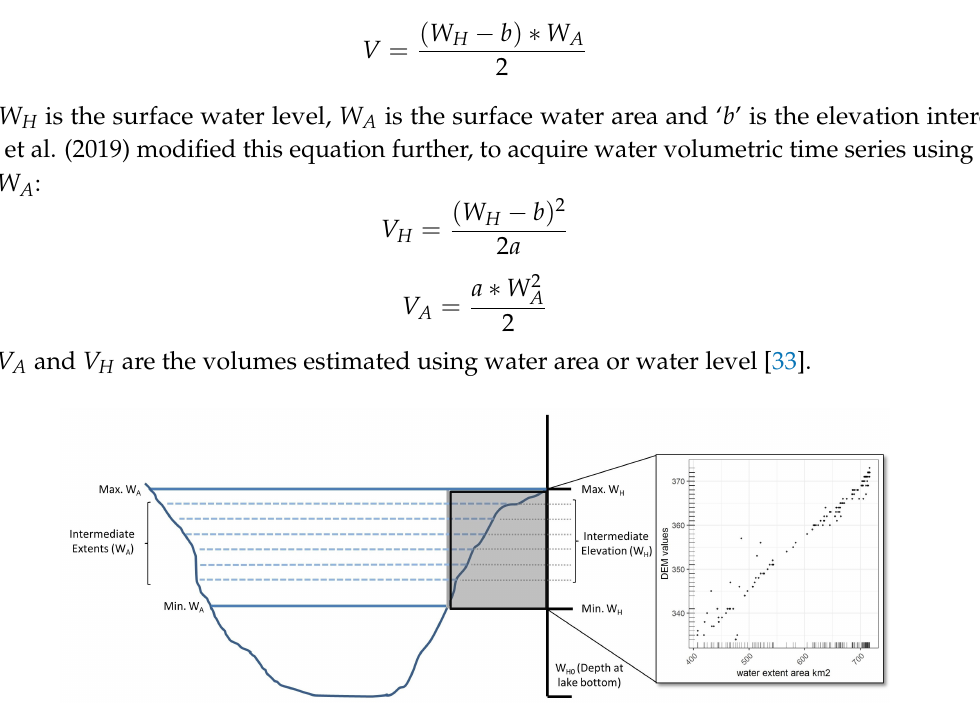
Figure 3. Reservoir cross-section depicting hypsometric relationship between surface water area extent and